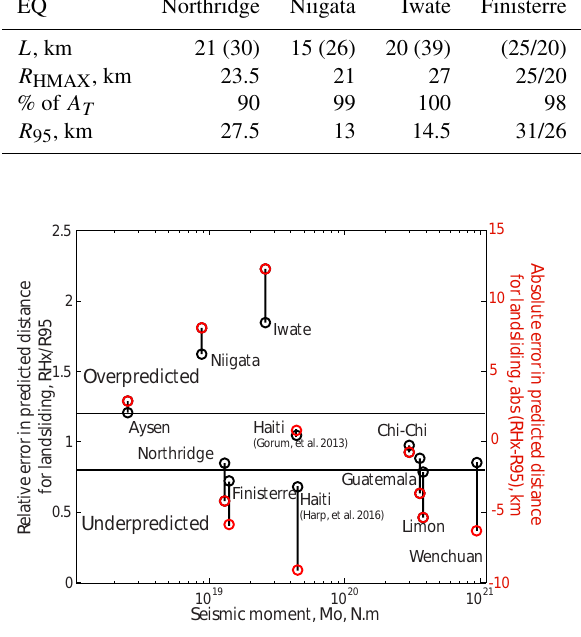
Figure 5. Relative and absolute errors in the prediction of the dis- tance from the wave emission line containing 95% of the total landslide area plotted against the seismic moment. Horizontal black lines delimit cases where the relative error is within < 20%. The absolute error (red circles) indicates the difference in kilometres be- tween the prediction and the boundary of 95% of the